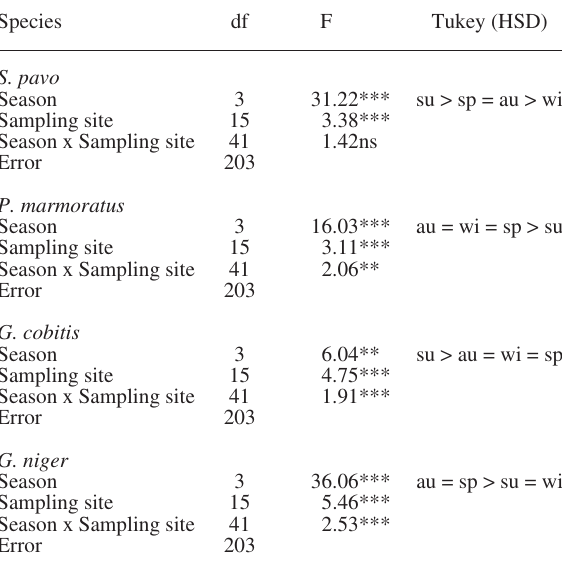
Table 3. − Results of two-way factorial analysis of variance per- formed on the fish density [ln (no. individuals/100 m 2 )] of the stud- ied species using season and sampling site as fixed factors. Results of Tukey (HSD) test for season comparisons are also shown (su = summer; au = autumn; wi = winter; sp = spring). Levels of signifi- cance: ns, not significant; ** p<0.01; *** p<0.001. Species